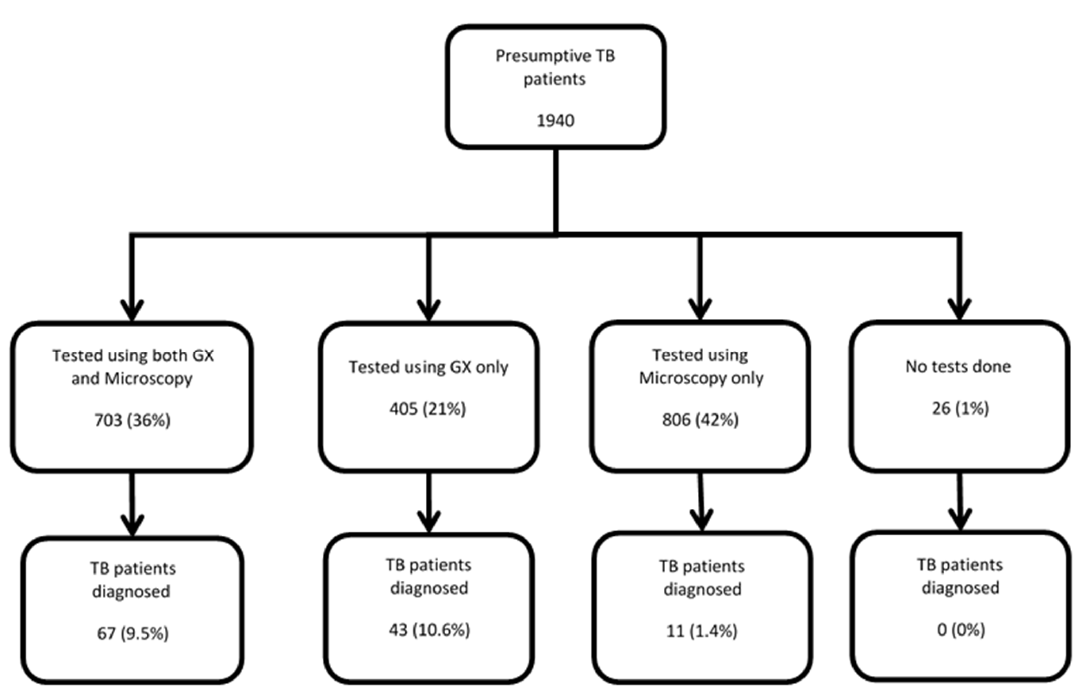
Figure 2. Presumptive TB patients tested using Xpert MTB/RIF assay and/or sputum smear microscopy and TB patients detected in selected health care facilities of Tashkent city and Bukhara regions of Uzbekistan, January–March 2019; TB = tuberculosis; RR = rifampicin resistance; GX = GeneXpert.